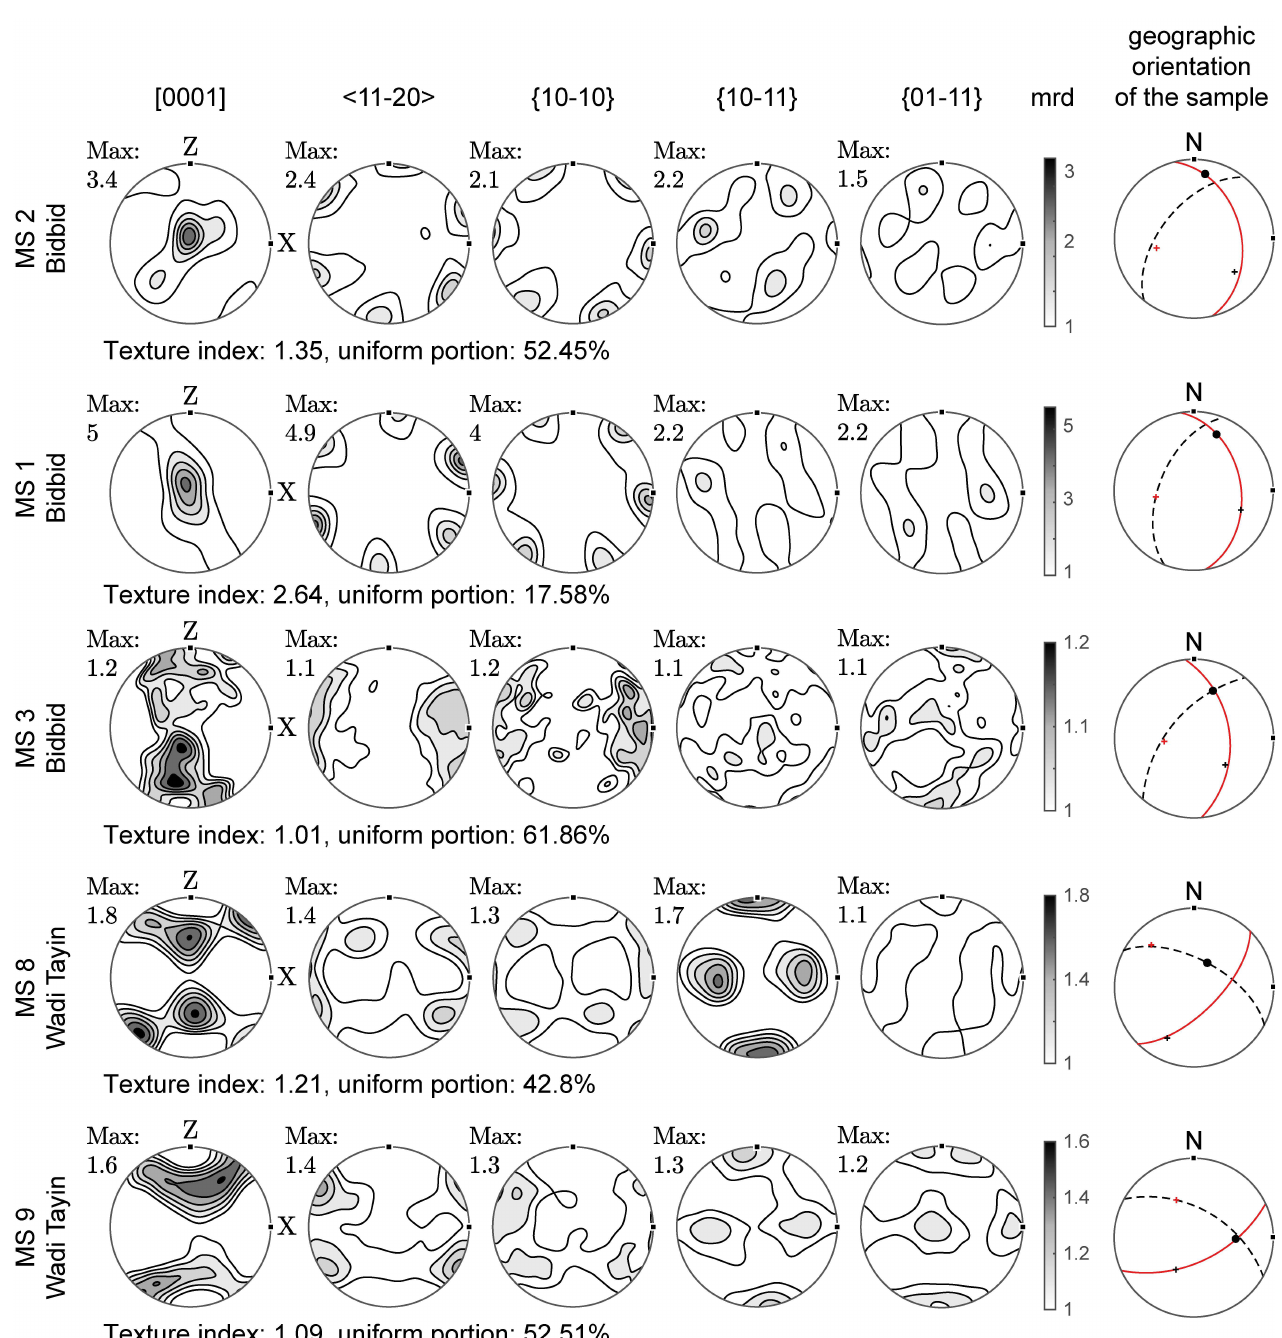
Figure 5. Recalculated quartz pole figure results from time-of-flight (ToF) measurements at SKAT, Dubna. Sections are perpendicular to the foliation and parallel to the X direction of the finite strain ellipsoid (S-N for MS 1, 2, and 3 and SW-NE for MS 8 and 9). The exact orientation is given in the Schmidt net (equal area and lower hemisphere projection) at the right; the red great circle represents the pole figure orientation (i.e., the XZ section). The dotted black great circle represents the foliation, and the black dot the stretching lineation (i.e., the X direction of the finite strain ellipsoid). All pole figures are plotted antipodally and in the upper hemisphere; m.r.d.: multiples of random distribution, max: maximum of magnitudes of